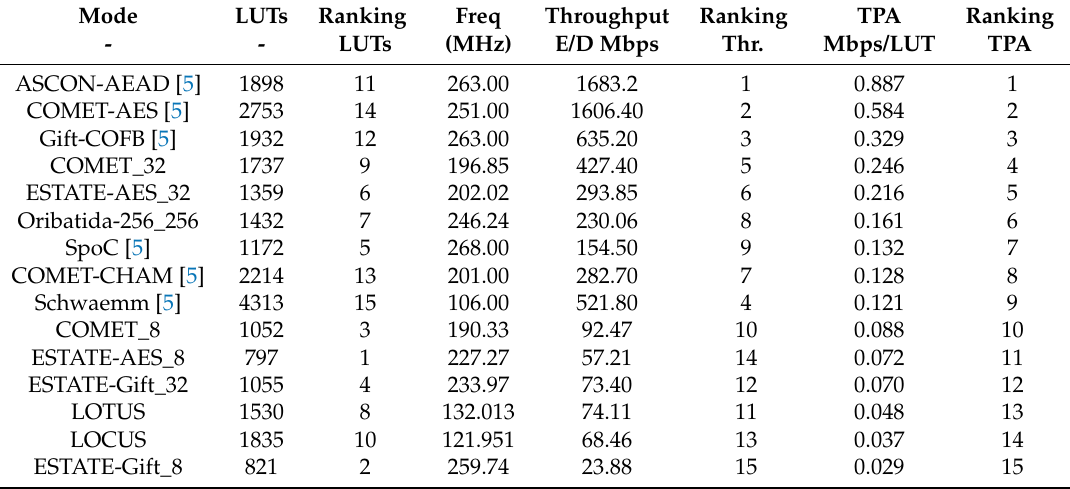
Table 4. Comparison of our LWC implementations regarding to the existing